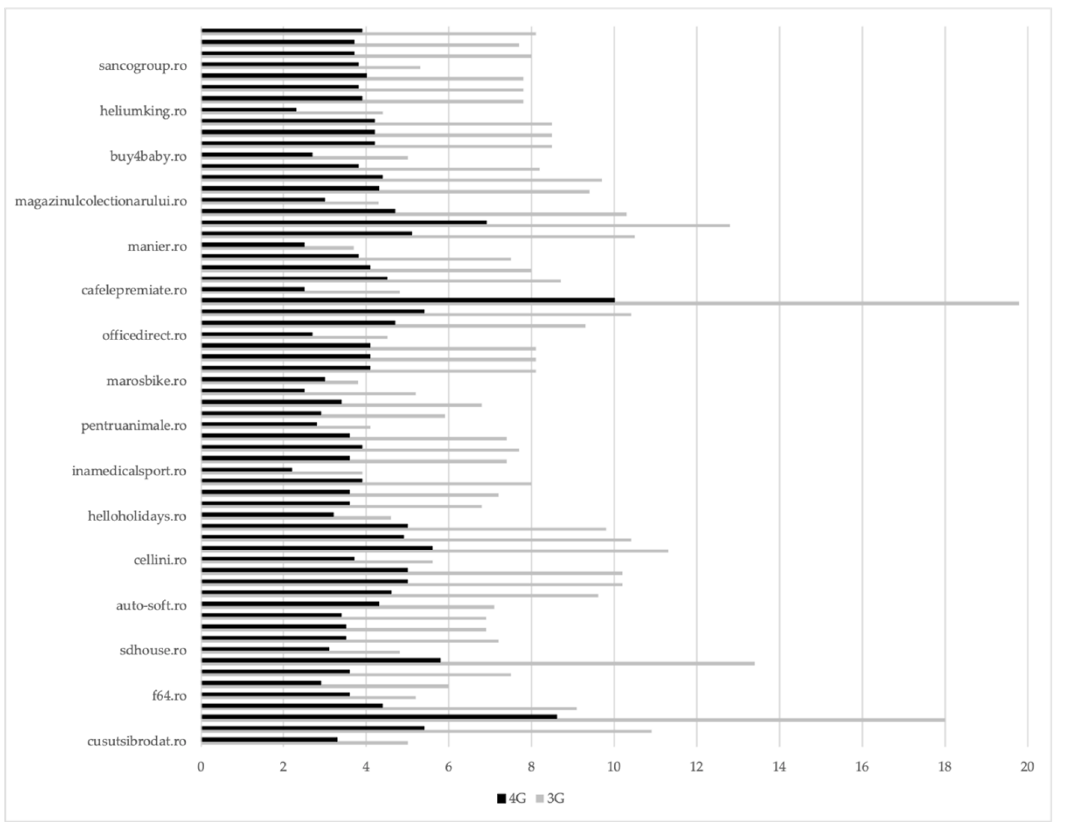
Figure 3. The differences between 3G and 4G networks regarding loading page speed.